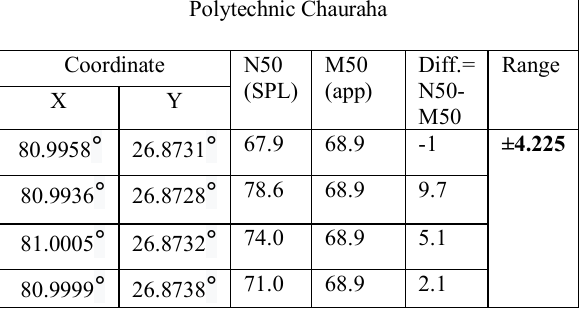
Table 1. Table showing the calibration using the L50 values from the mobile app and SPL.